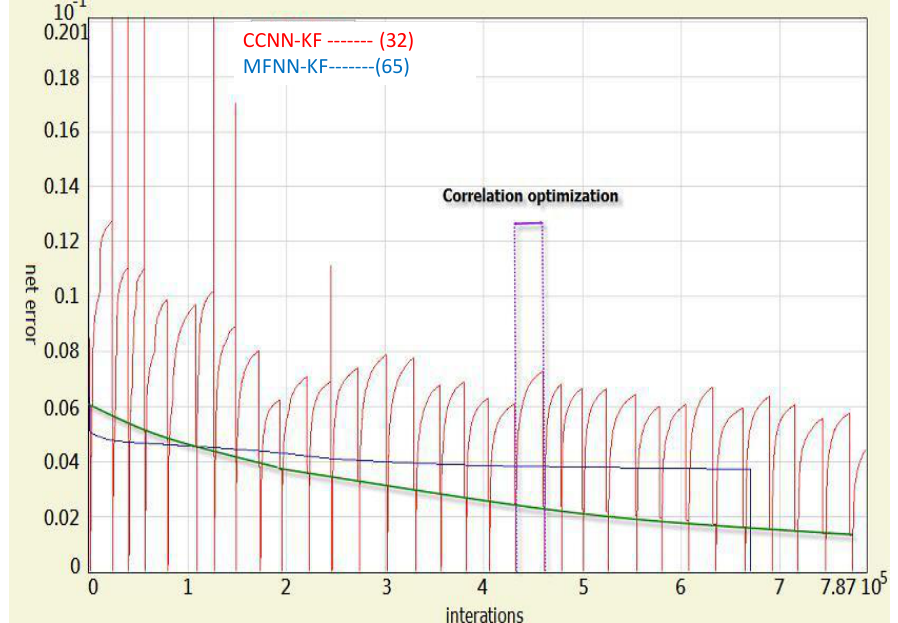
Figure 14 . The comparison of the learning behaviors of CCNN-KF and MFNN-KF based